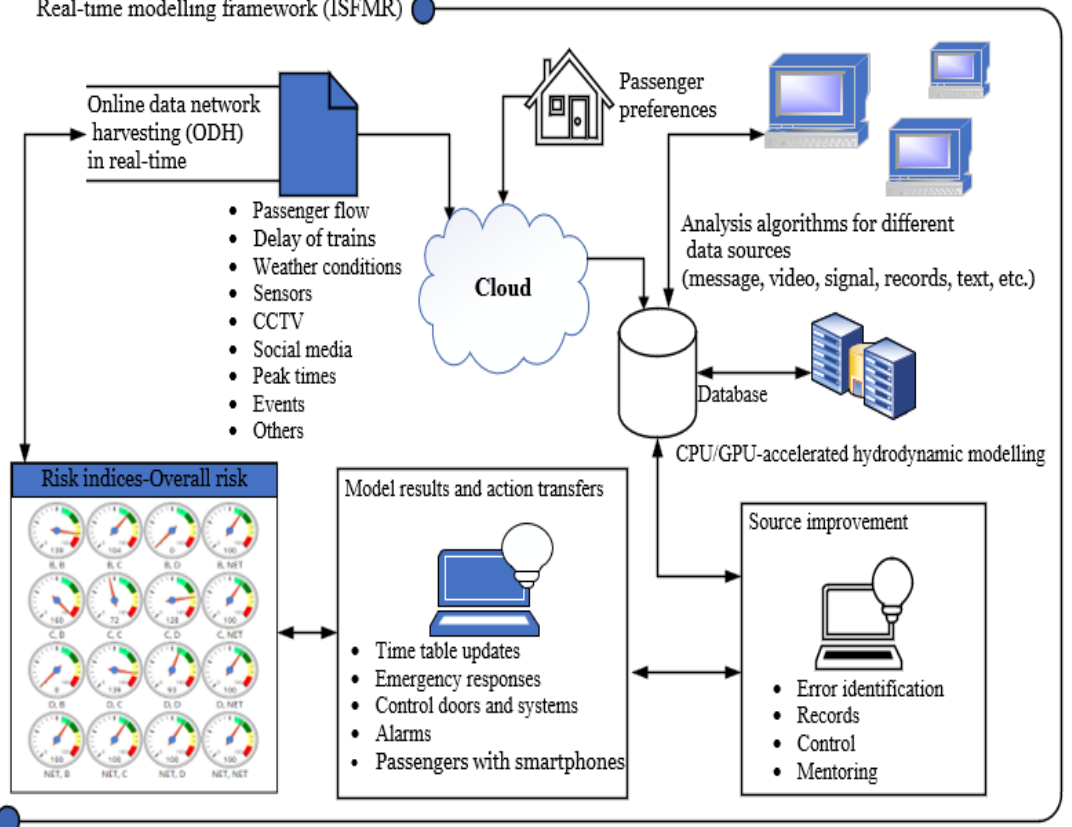
Figure 1. Process framework suggested for the Intelligent System for Managing Risks (ISFMR) in the railway stations.